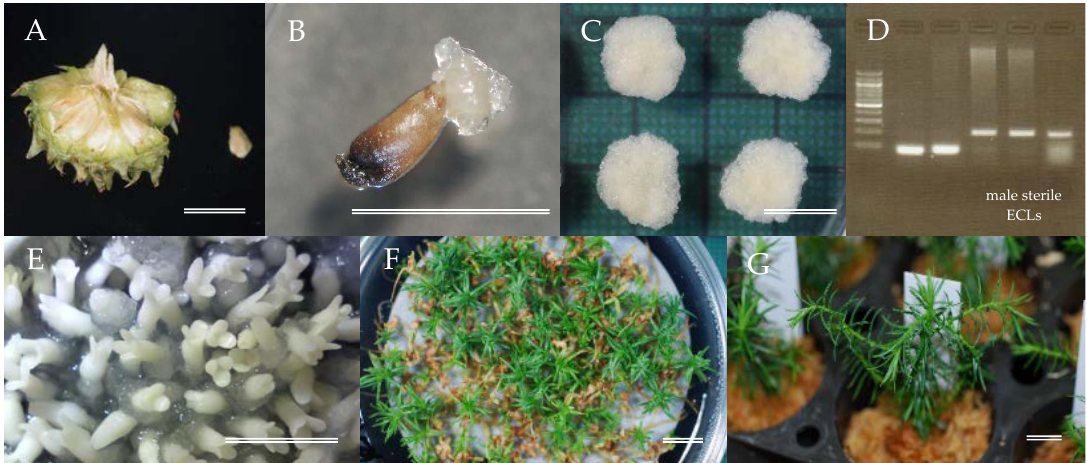
Figure 8. Somatic embryogenesis (SE) and male sterile plants (MSPs) production from embryogenic cells originated from sugi seed families carrying the male sterility gene MS1 , ( A ) cone and isolated seed, ( B ) SE initiation, ( C ) proliferation of embryogenic cells, ( D ) selection of male sterile ECLs by MAS, ( E ) somatic embryo maturation from selected lines, ( F ) somatic embryo germination and plant conversion, ( G ) acclimatized somatic plants. Bars 1 cm.